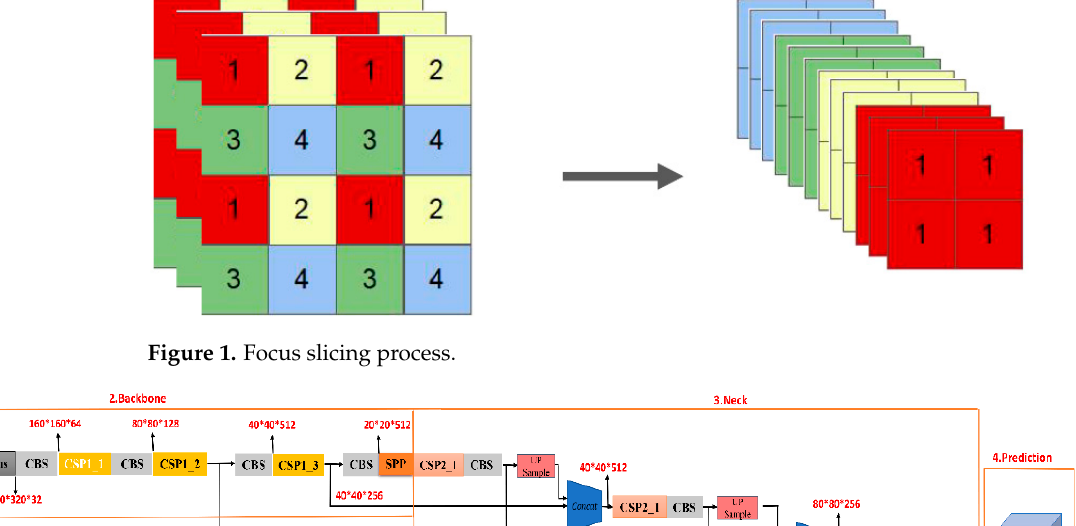
Figure 1. Focus slicing process.